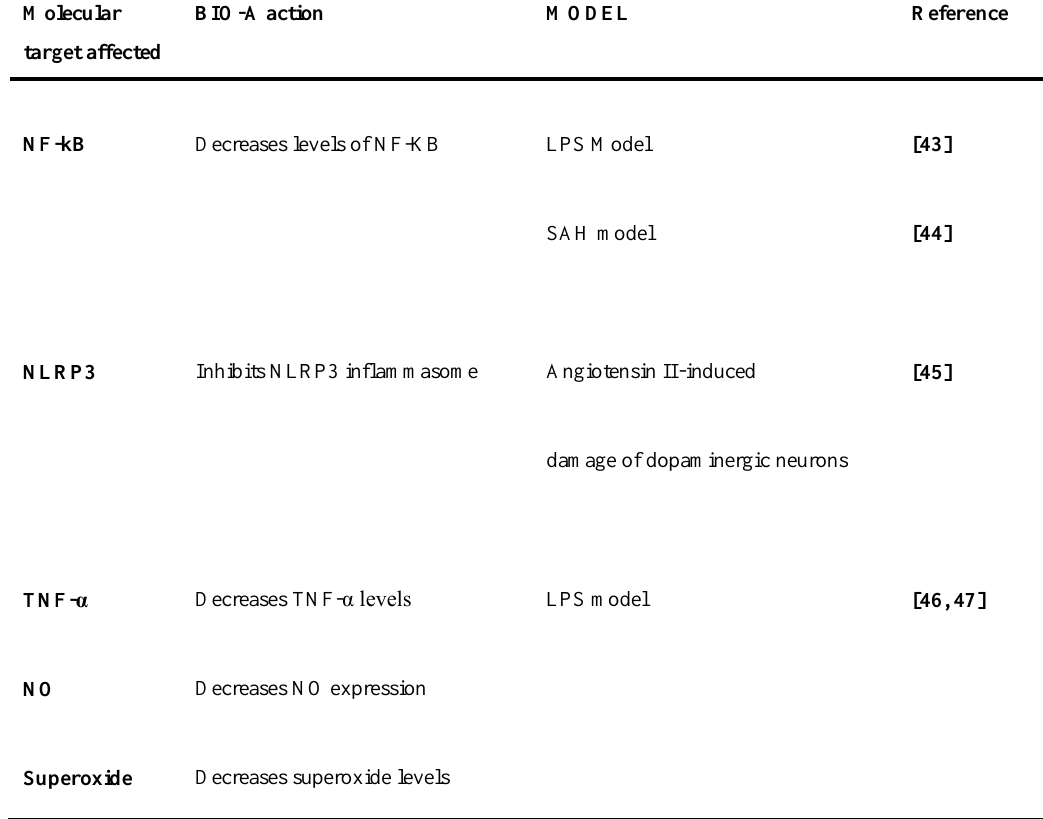
Table 1. BIO-A protects against neuroinflammation